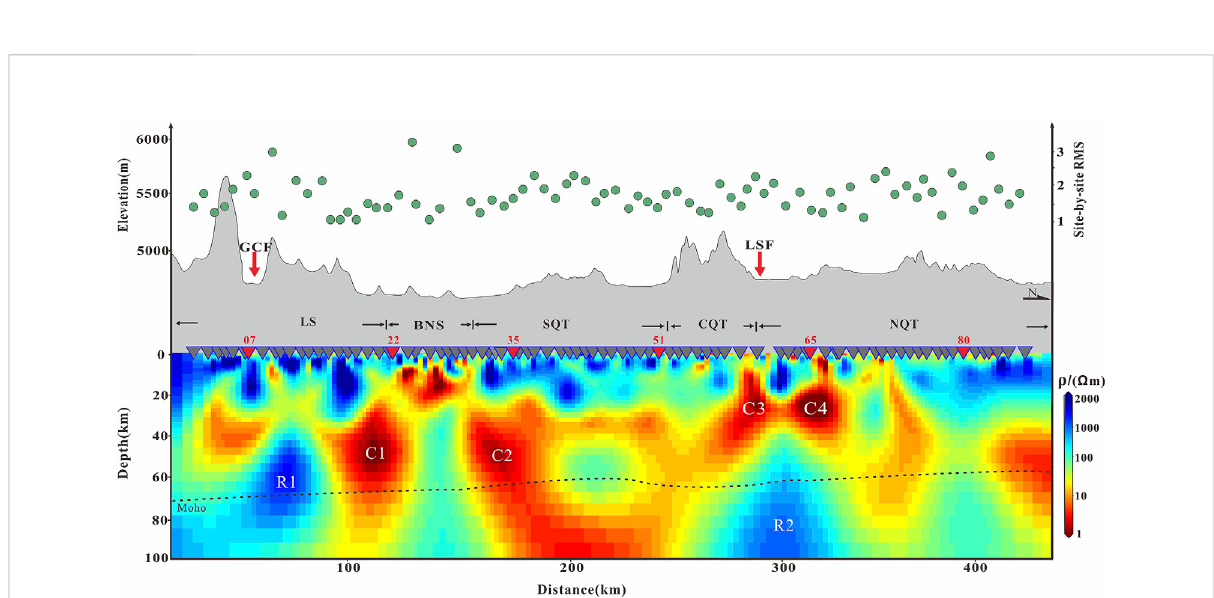
FIGURE 6 2-D electrical structure model. The green circles represent the RMS distribution. LS, Lhasa terrane; SQT, southern Qiangtang terrane; CQT, central Qiangtang terrane (central uplift zone); NQT, northern Qiangtang terrane, BNS, Bangong-Nujiang suture; LSF, Longmu Tso-Shuanghu fault; GCF, Gyaring co fault; Moho depth derived from (Gao et al., 2013; Lu et al., 2015).